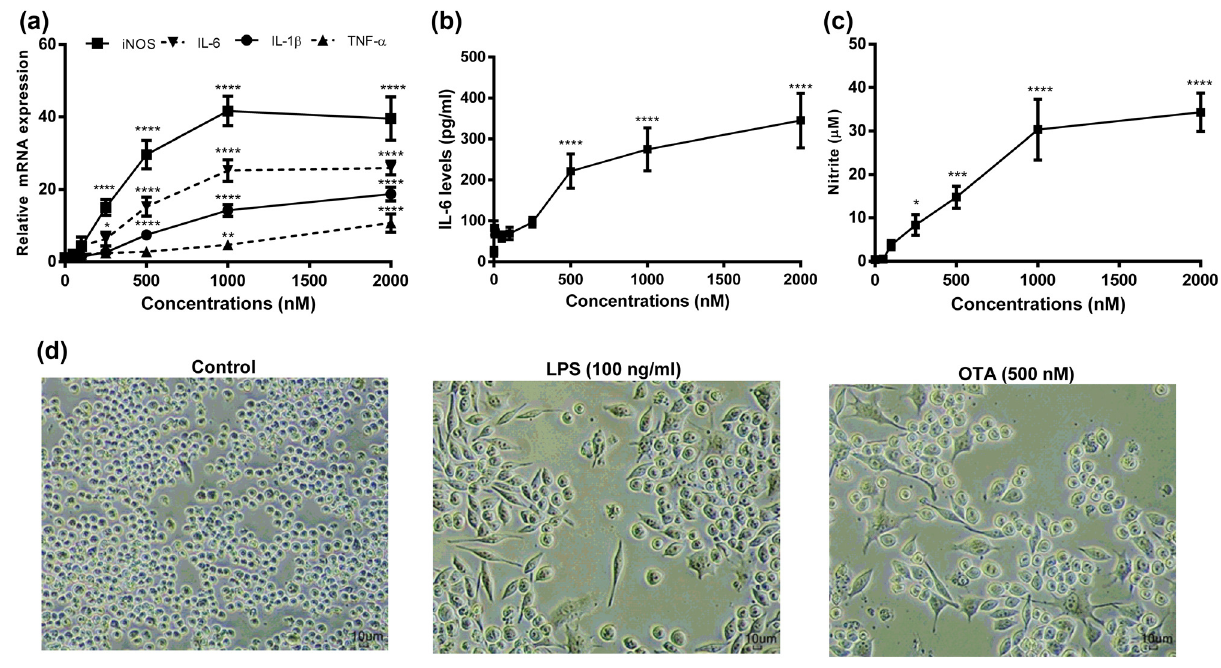
Figure 2: E ff ects of ochratoxin A on microglial in fl ammatory responses. BV - 2 cells were incubated with di ff erent concentrations of OTA ( 50, 100, 250, 500, 1,000, and 2,000 nM ) for 24 h. ( a ) mRNA levels of IL - 6, TNF - α , IL - 1 β , and iNOS examined by qRT - PCR. ( b ) The IL - 6 levels measured by ELISA. ( c ) NO levels measured by Griess reagent. ( d ) Cell morphology at 24 h obtained by taking phase - contrast pictures with an inverted Nikon microscope ( 10 ×) . Data were expressed as mean value ± SD from at least three independent experiments. * p < 0.05, ** p < 0.01, *** p < 0.005, and **** p < 0.0001 compared to the control